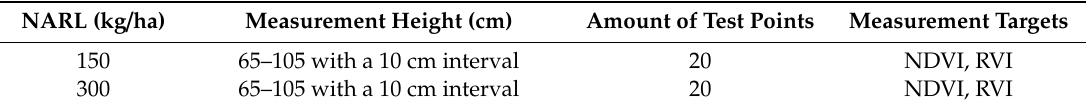
Table 2. Field test scheme.